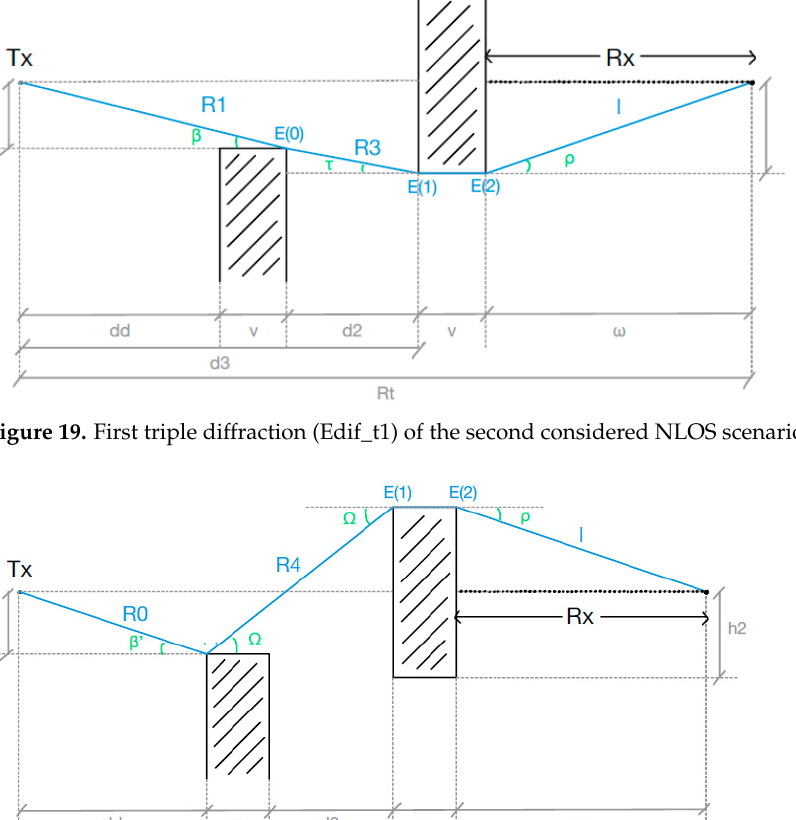
Figure 19. First triple diffraction (Edif_t1) of the second considered NLOS scenario.